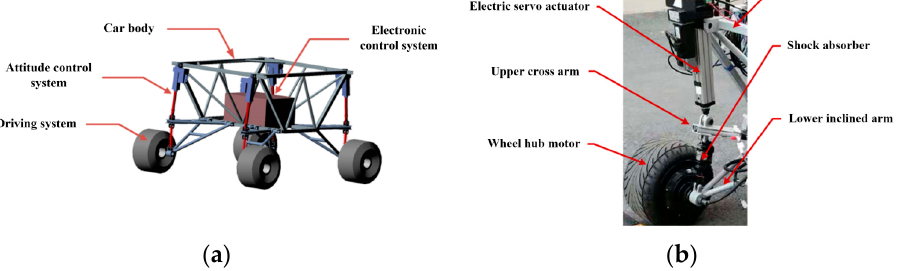
Figure 1. All-terrain vehicle structure: ( a ) All-terrain vehicle 3D model; ( b ) All-terrain vehicle real model.